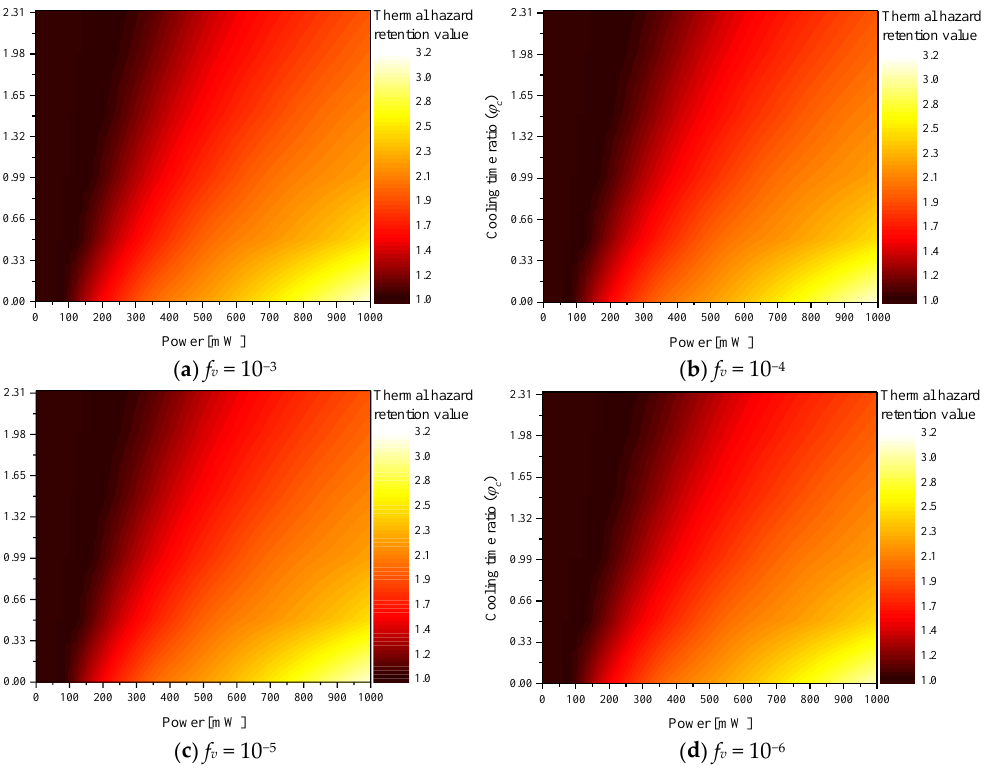
) for various cooling time ratios ( ϕ c H